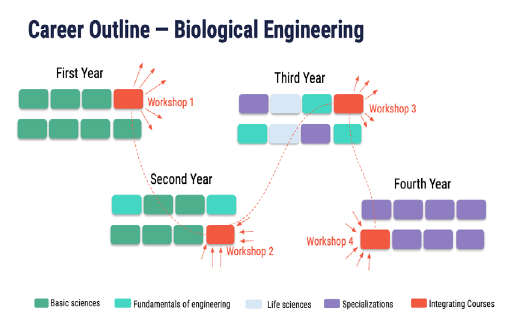
Figure 1. Outline of the undergraduate degree